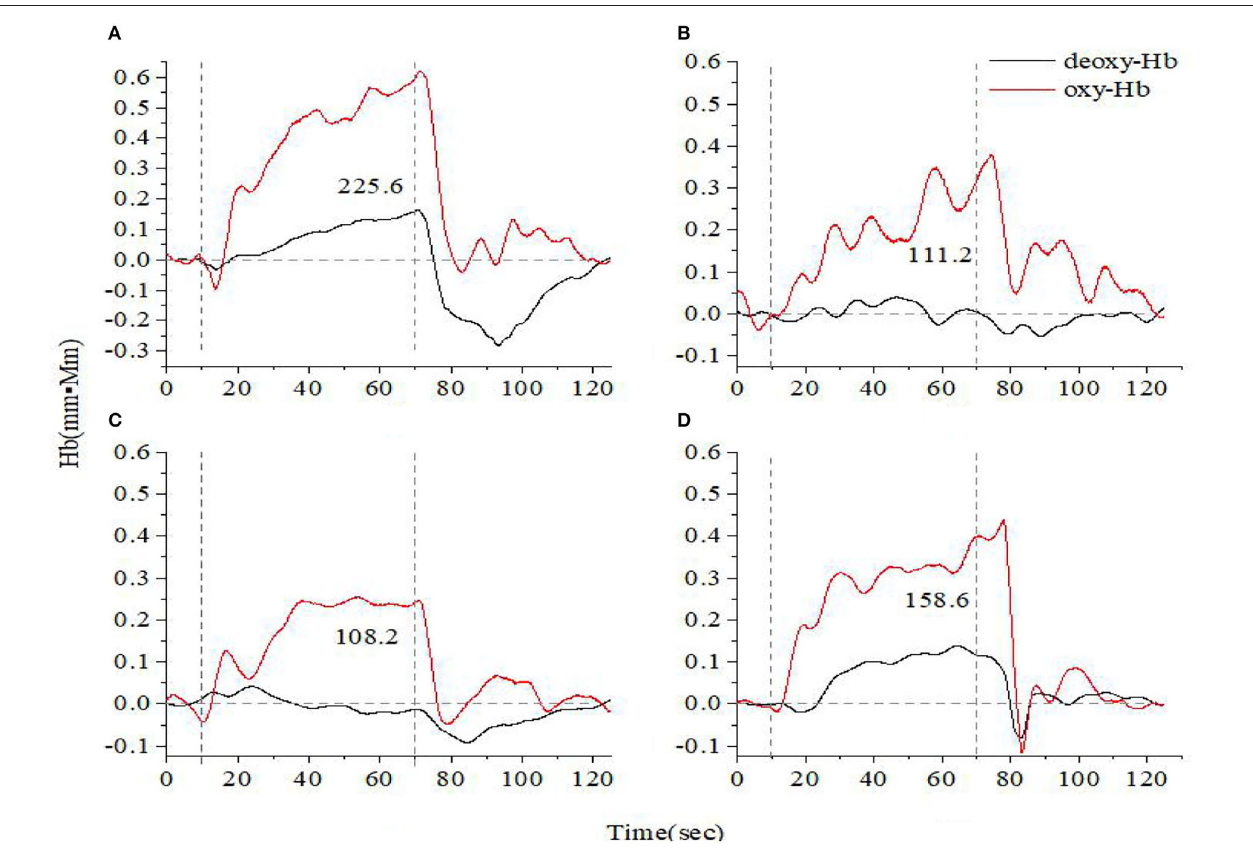
FIGURE 2 | Time course of hemoglobin concentration changes in a representative healthy control (A) and a representative anxiety and depression patient at the acute (B) , consolidation (C) , and maintenance stages (D) . All of them completed the high-level cognition task. The red line indicates the amount of change in oxyhemoglobin concentration (oxy-Hb), and the black line indicates the amount of change in deoxyhemoglobin concentration (deoxy-Hb). The numbers indicate integral